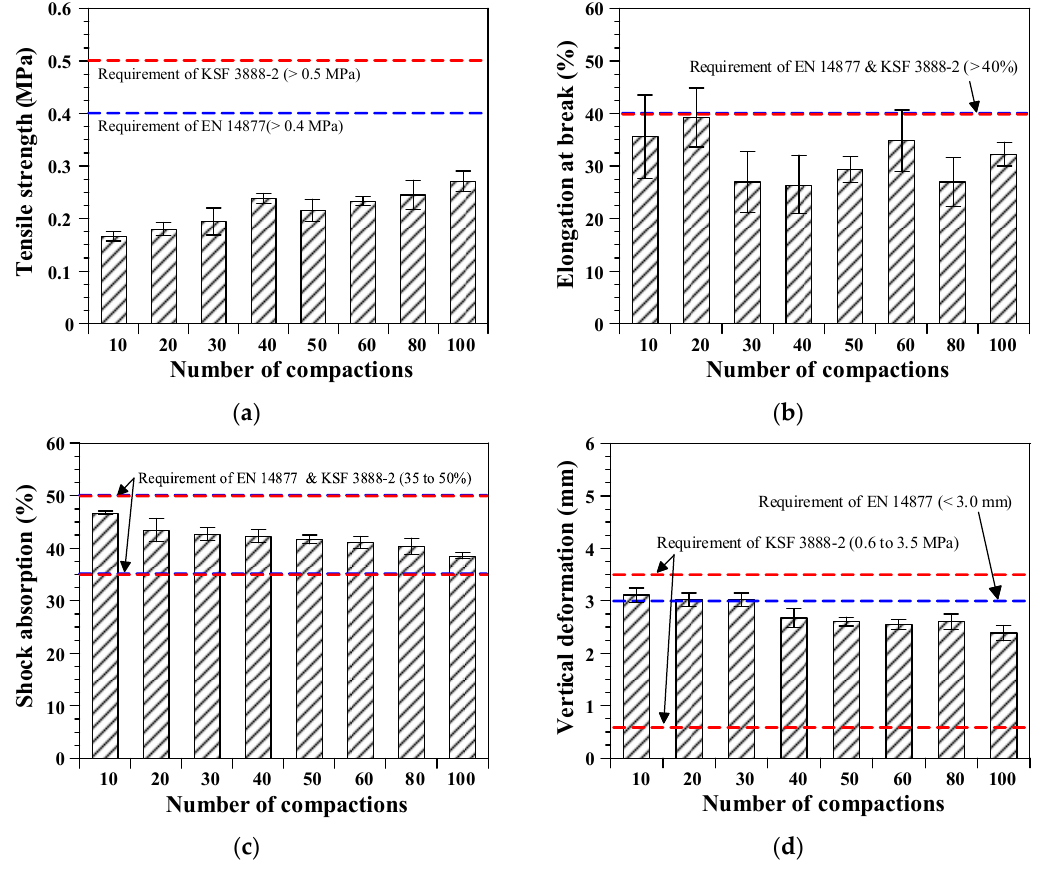
Figure 6. Effects of the number of compactions: ( a ) Tensile strength; ( b ) elongation at break; ( c ) shock absorption; and ( d ) vertical deformation.